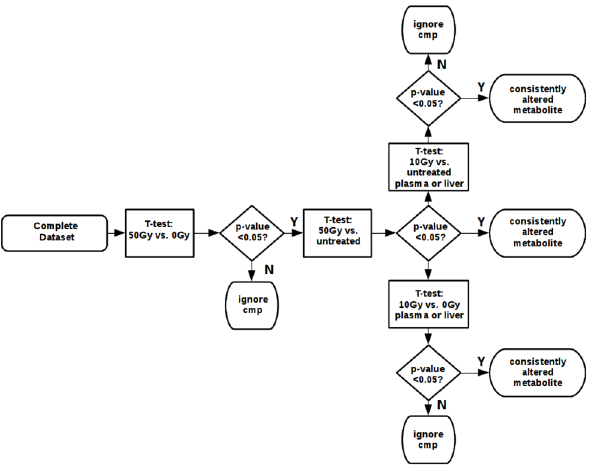
Fig 2. Decision Tree for metabolite validation. The decision tree approach that was used to confirm important metabolite signatures in the WLI experiments is illustrated. Consistently altered metabolites between groups were determined first by comparison of the 50 Gy vs. 0 Gy data sets, then by validation of the metabolite in the 50 Gy vs untreated data sets. If the metabolite was still unconfirmed, it was tested as being significant in the 10Gy vs. 0 Gy plasma or liver data set, or the 10 Gy vs. untreated data